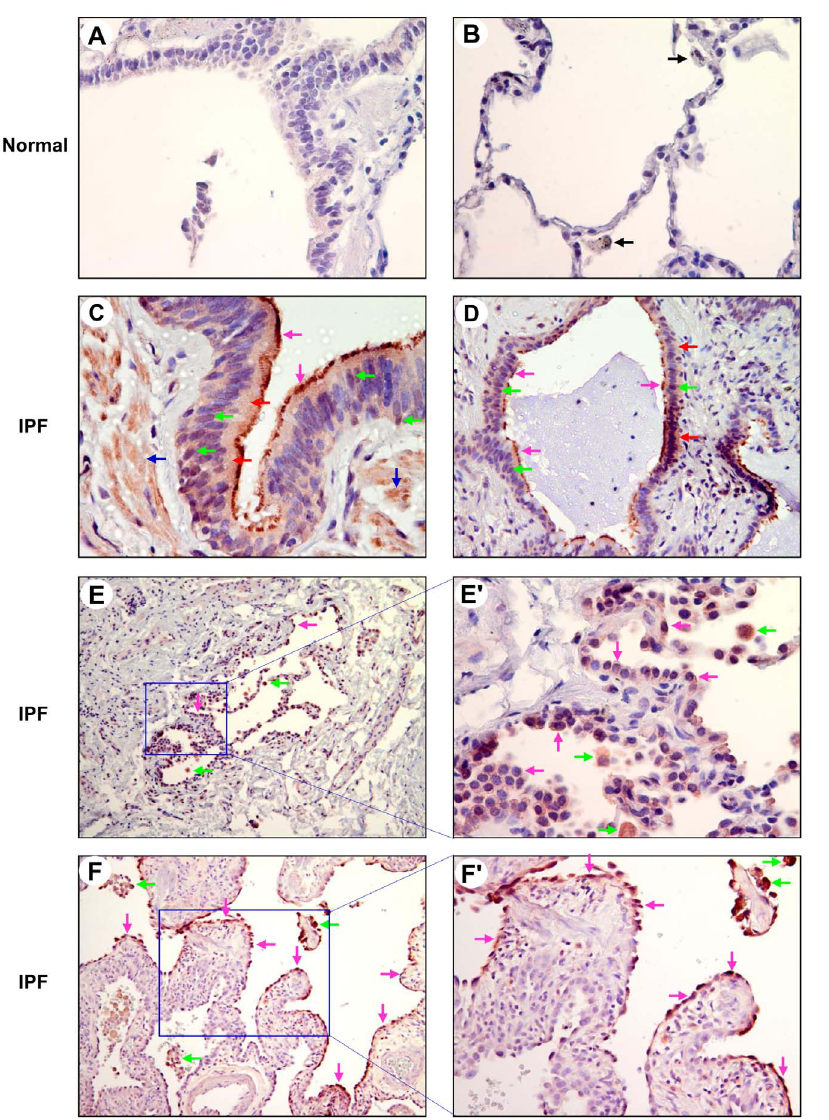
Figure 5. PKD family kinases are activated in bronchiolar and alveolar epithelia as well as macrophages in IPF. Normal and IPF lung sections were subjected to immunohistochemical analysis by using a phospho-specific PKD-pSer744/748 antibody at a dilution of 1:50. A and B: normal lung BECs, AECs, and macrophages (black arrows) were all stained negative by PKD-pSer744/748 antibody. Final magnification: 6 400. C and D: positive immunoreactivities (red) were detected in the cilia (pink arrows), cytoplasm (red arrows) and nuclei (green arrows) of IPF bronchiolar (C, 6 400) and honeycomb cyst (D, 6 200) epithelia. Positive staining was also observed in the smooth muscle cells (C, blue arrows) surrounding small airways. E–F 9 : in IPF alveoli, PKD phosphorylation on Ser-744/748 (red) was readily detected in most of the hyperplastic type II pneumoctyes (E and E 9 , pink arrows) and the regenerative AECs (F and F 9 , pink arrows) lining remodeled fibrotic alveolar septa and/or fibroblast foci. It should be noted that alveolar walls grew and expanded towards the regenerative AECs with activated PKDs (F and F 9 ). Strong positive immunoractivities (red) were also observed in alveolar macrophages (green arrows). The regions indicated in panels E and F ( 6 100) are shown at higher magnification in E 9 ( 6 400) and F 9 ( 6